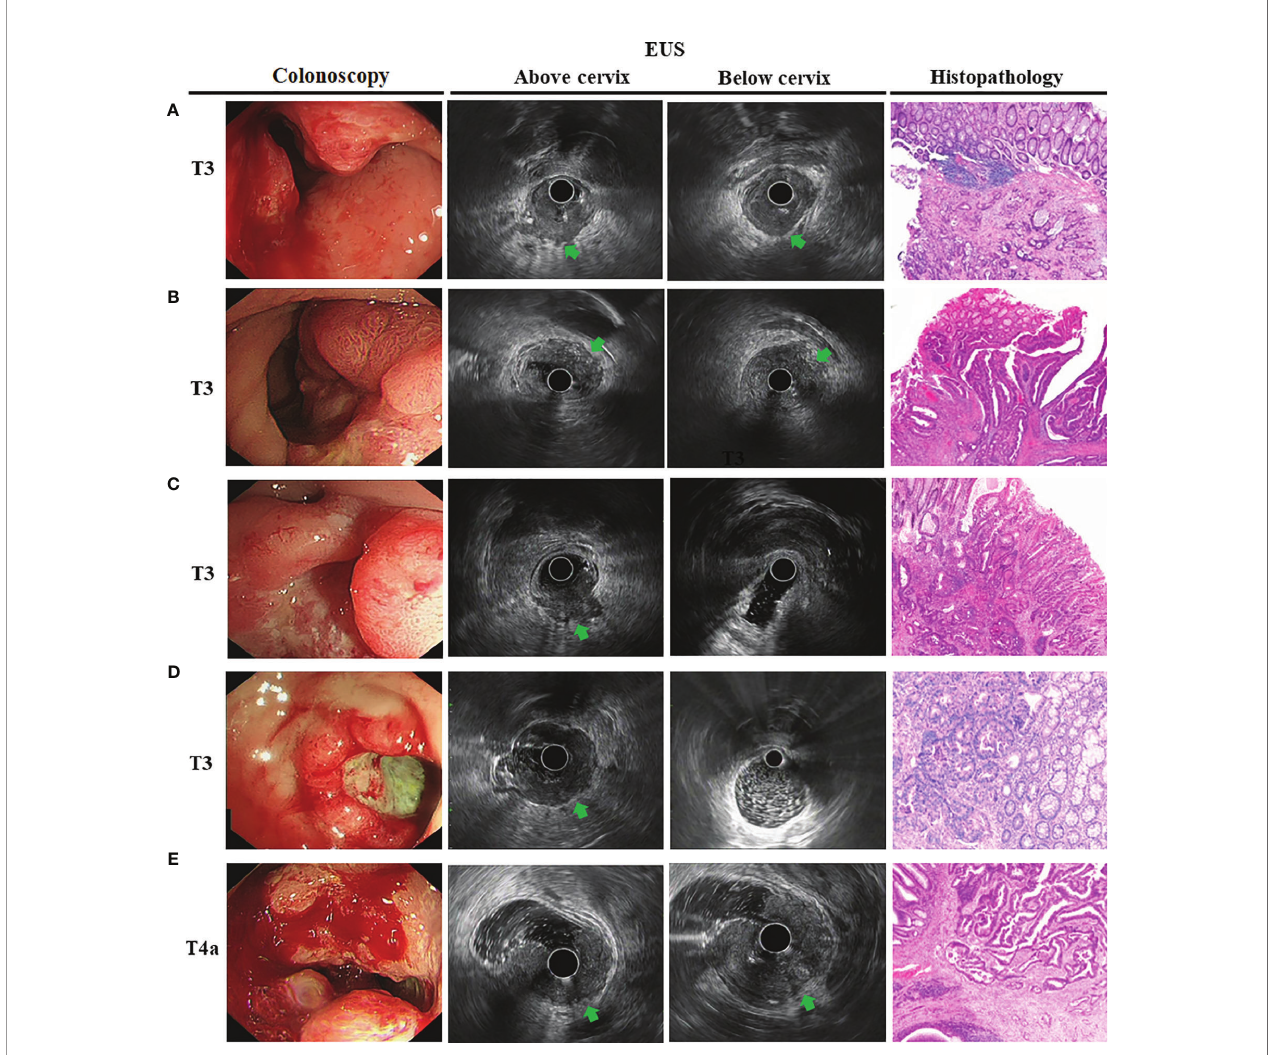
FIGURE 4 | The endoscopic ultrasonography image features in T3 and T4a tumor T stage for female. Endoscopic image showed a large ulcer located the rectal wall covering with moss. (A) . EUS image showed an obviously thick hypoechoic lesion that spread throughout the entire wall. The lesion located at posterior rectum and below the cervix ( arrowheads ); (B) The lesion located at anterior rectum and below the cervix ( arrowheads ); (C) The lesion located at posterior rectum but above the cervix ( arrowheads ). This T3 tumor penetrates the rectal wall and invaded perirectal fat; (D) The lesion located at anterior rectum and above the seminal vesicles. However, hypoechoic lesion invaded to entire wall with an intact serosa layer ( arrowheads ), meaning that the tumor is still limited to the rectal wall. The surgical specimen con fi rmed tumor con fi ned to the subserosa; (E) The lesion located at anterior rectum and above the seminal vesicles. However, hypoechoic lesion invaded to entire wall and serosal layer was irregularities in the outer edge of the rectal wall ( arrowheads ), meaning that the tumor had spread outside the serosa. The surgical specimen con fi rmed lesion in fi ltrated to the serosal